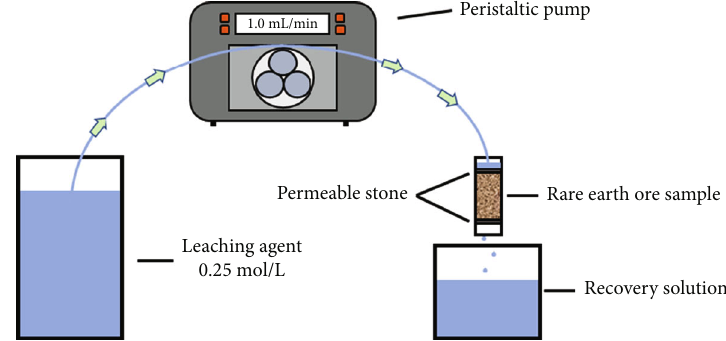
Figure 4: Schematic diagram of laboratory test.